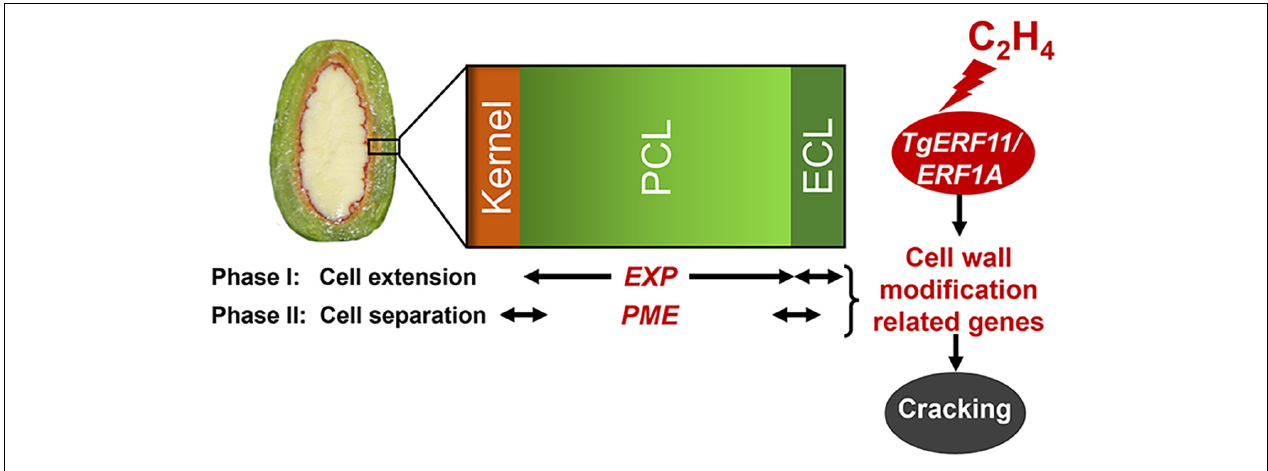
FIGURE 8 | Proposed model for the regulation of cell wall modification genes ( EXP and PME ) by ethylene signal transcription factors ( ERF11 and ERF1A ) in the presence of ethylene emissions during aril cracking in T.